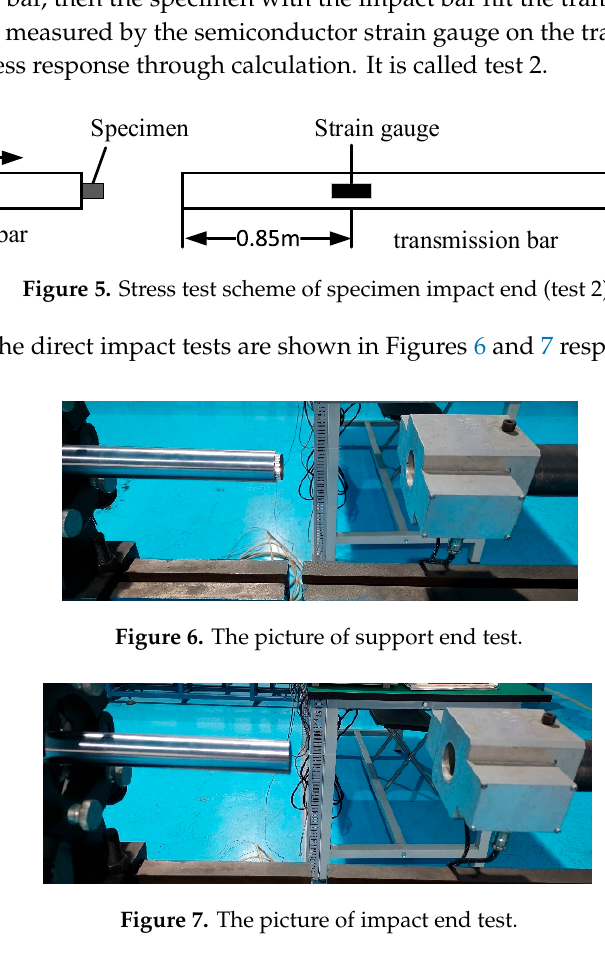
Figure 4. Stress test scheme of specimen support end (test 1).